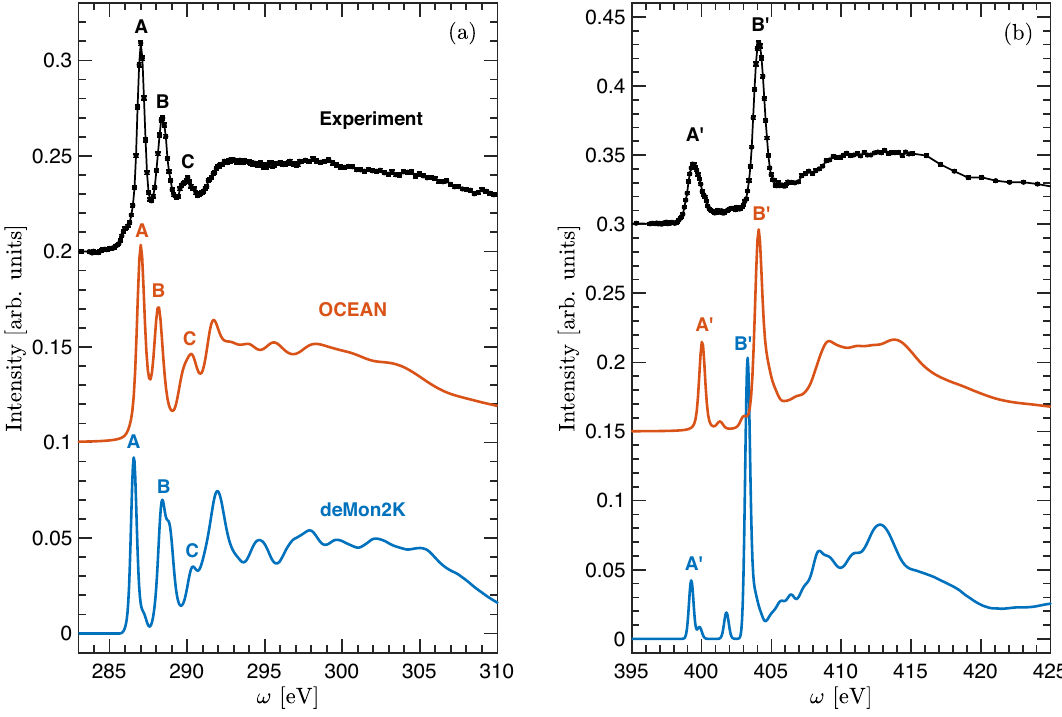
Figure 1. Experimental and theoretical 1s carbon ( a ) and nitrogen ( b ) X-ray Raman spectra of